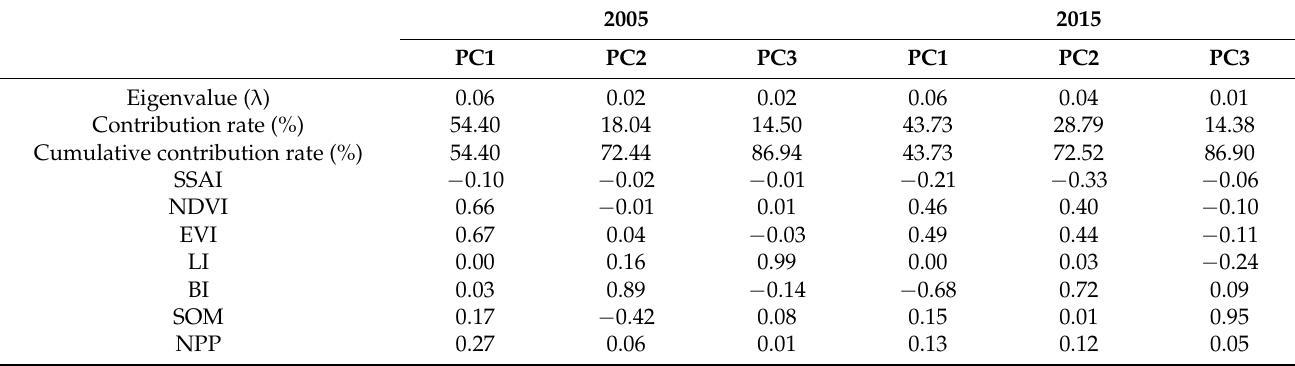
Table A3. Eigenvalues and correlation coefficient matrix of principal components of state indicators in 2005 and 2015.